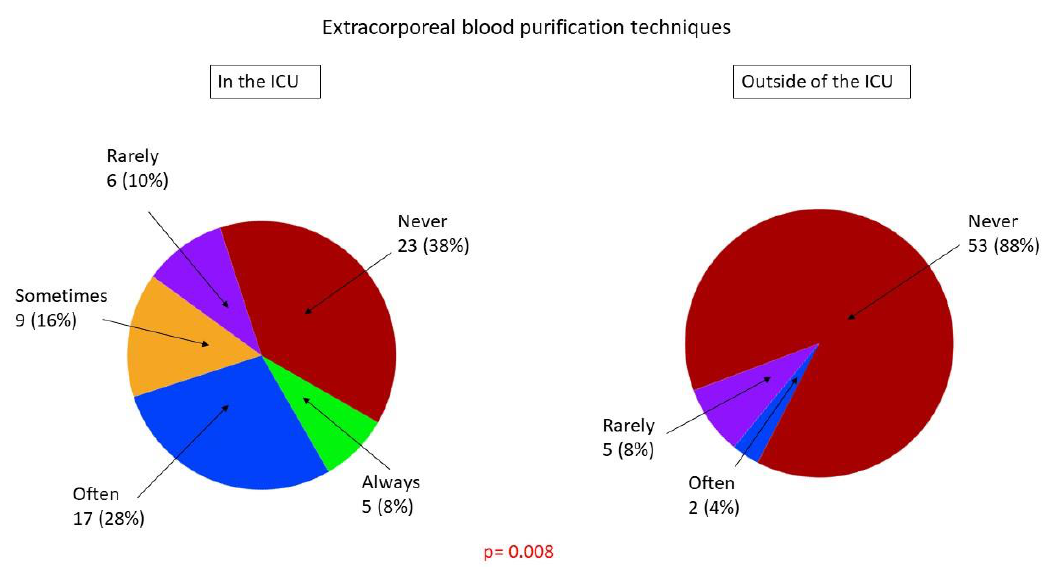
Figure 5. The use of extracorporeal blood purification techniques as an adjunct to hemodynamic support.